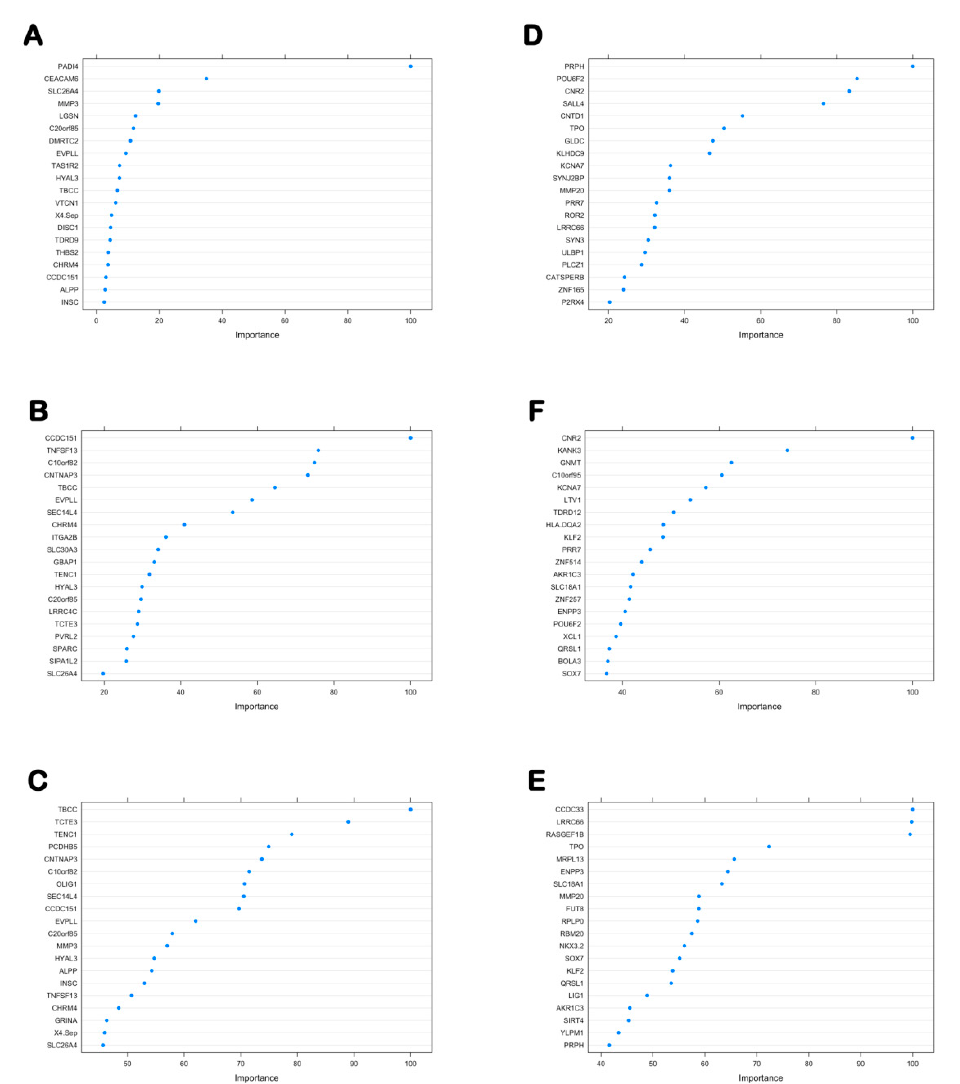
Figure 7. Top 20 genes and importance scores of the hypo-up genes and hyper-down genes in each classifier. Top 20 genes and importance scores of the hypo-up genes in ( A ) the gene expression classifier, ( B ) the gene methylation classifier based on CpGs in all of the regions, and ( C ) the gene methylation classifier based on the CpGs in the dominant regions. Top 20 genes and importance scores of the hyper-down genes in ( D ) the gene expression classifier, ( E ) the gene methylation classifier based on the CpGs in all of the regions, and ( F ) gene methylation classifier based on the CpGs in the dominant regions. Table 3. Gene symbol and importance scores of 46 hypo-up genes in gene expression classifier and gene methylation classifiers.